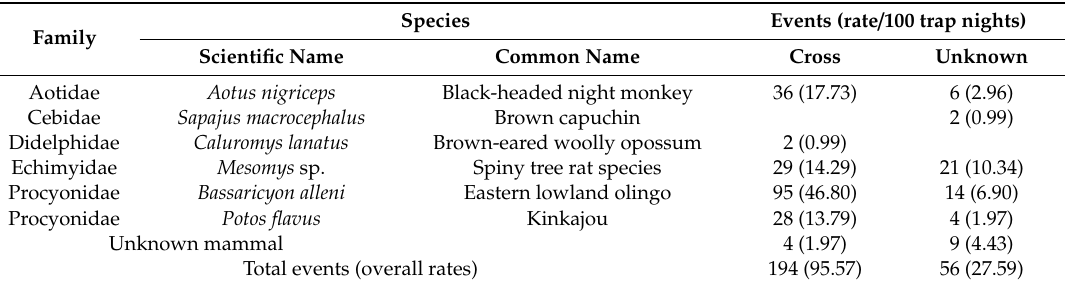
Table 2. Events and rates (events / 100 trap nights; 203 nights total) of mammal species recorded on the SACB, either crossing or exploring the bridge without a confirmed crossing (unknown). All events occurred at night except for one of the two events for Sapajus macrocephalus . Species Events (rate / 100 trap Family